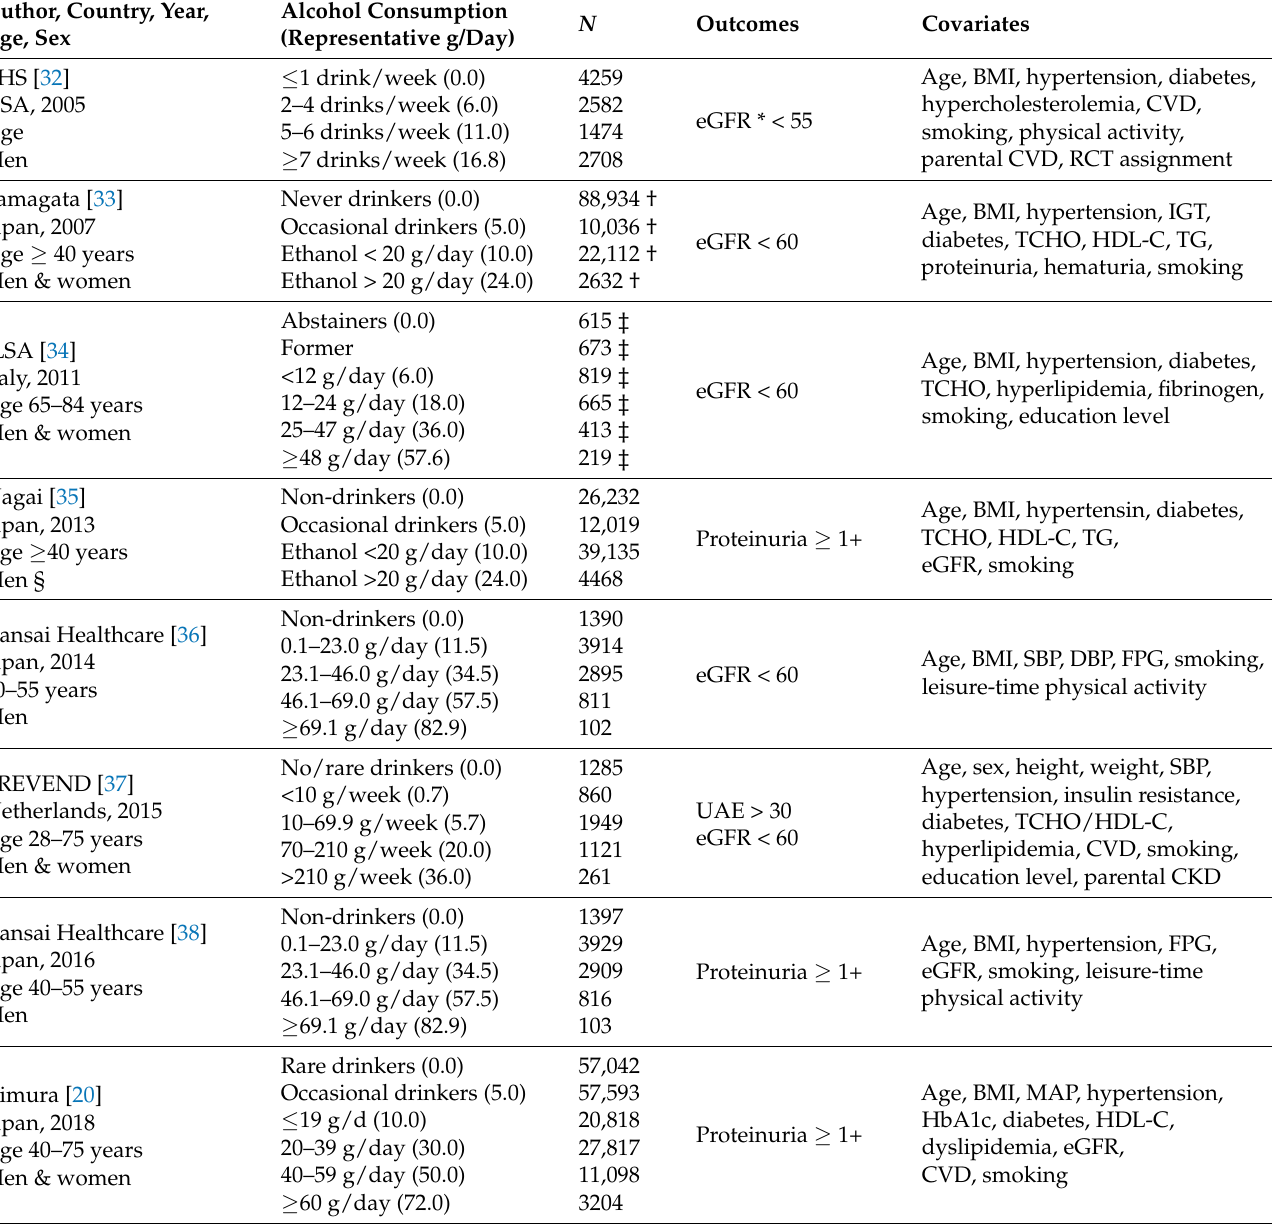
Table 1. Alcohol consumption categories and outcomes in 12 publications from 11 cohort